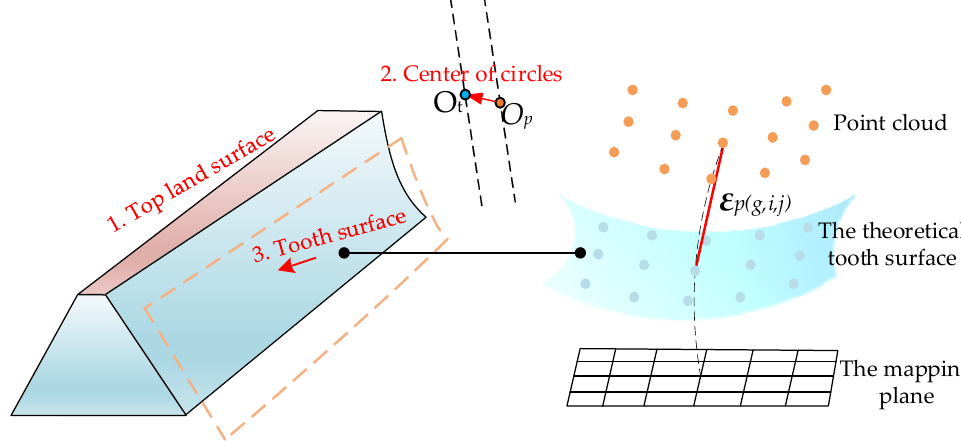
Figure 4. The three-stage alignment for top land surface, center of circles, and tooth surface. (1) The first stage